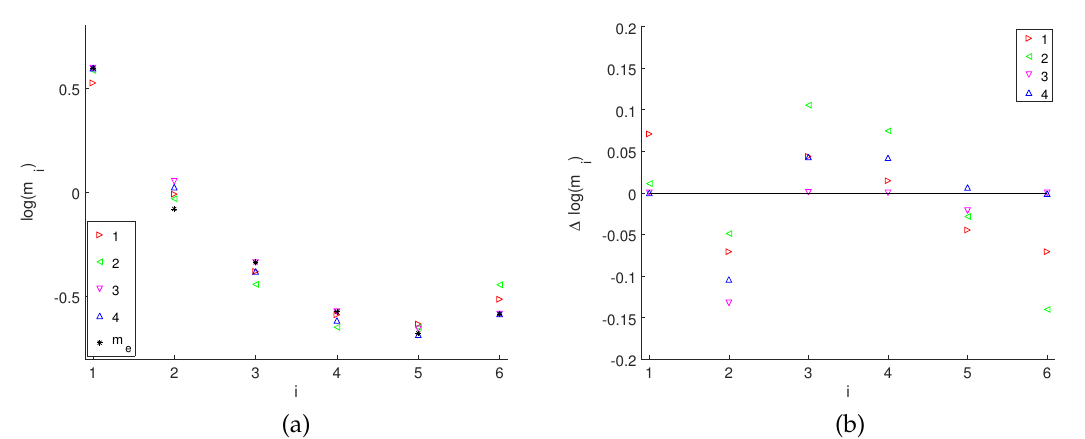
Figure 8. ( a ) theoretical values of the logarithms m i (asterisk * marks measured values) describing average values of 25-mm pipes; ( b ) deviations of theoretical logarithms of the values of m i from logarithms of the values m e obtained experimentally, i = 1, ..., 6 for criteria 1–4. i